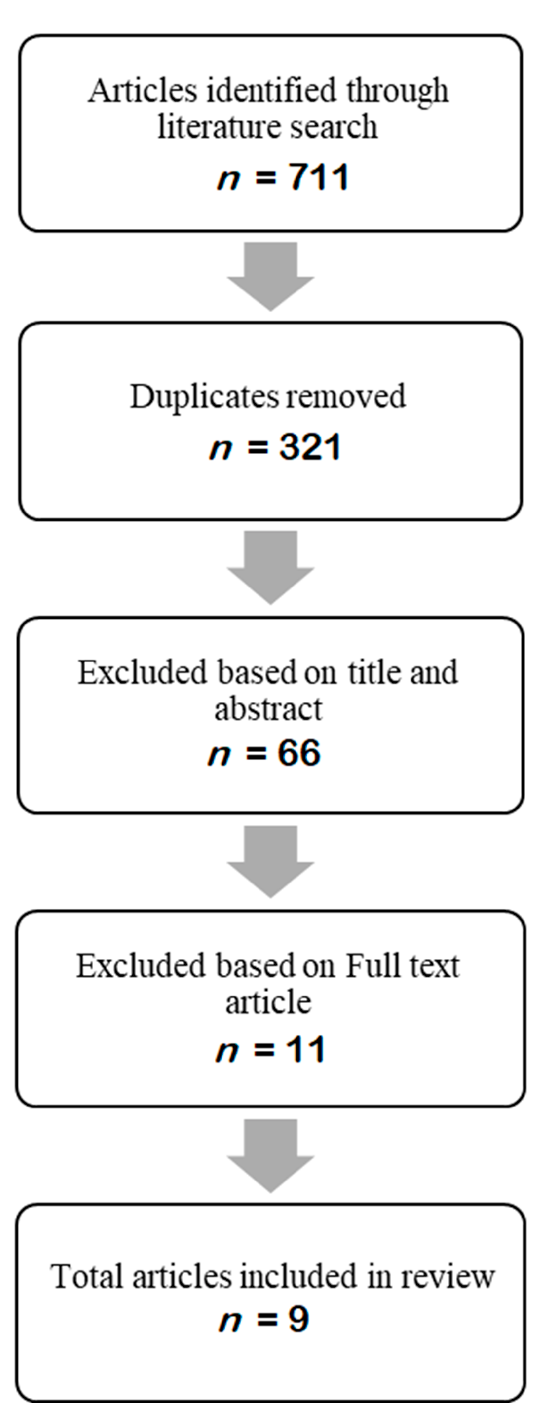
Figure 1. Flowchart of studies included in this systematic